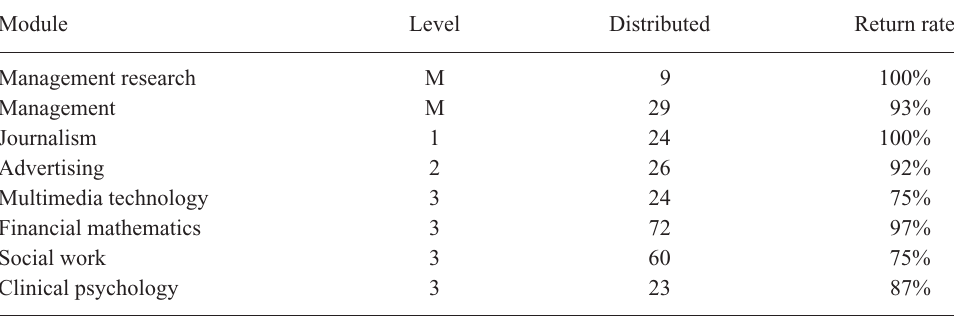
Table 1. Distribution and return rate of the survey. Module Level Distributed Return rate